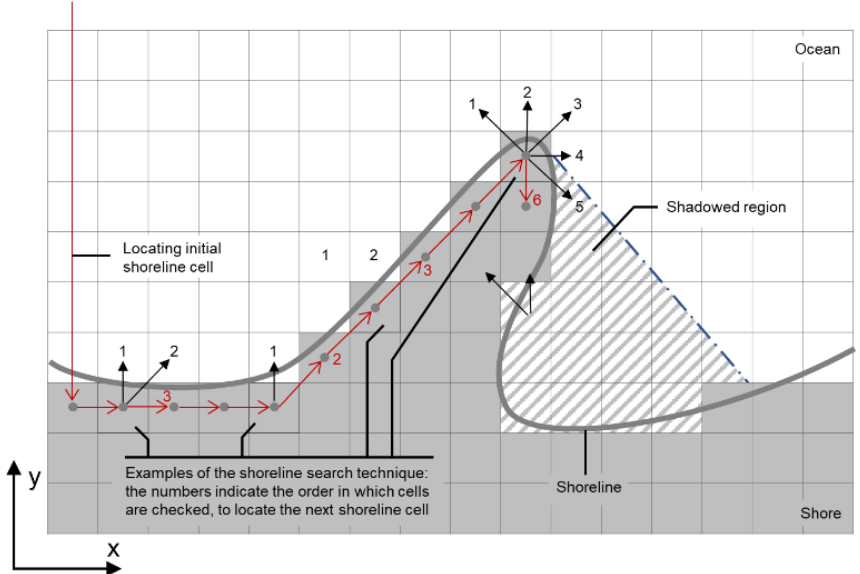
Figure 5. A schematic of the shoreline search technique used in CEM (and CEM2D) to map the x and y locations of the shoreline cells. The number in square brackets denotes the shoreline cell number that is associated with a particular x and y value, and the number on each arrow is the iteration of the clockwise search from the shoreline cell where it originates.